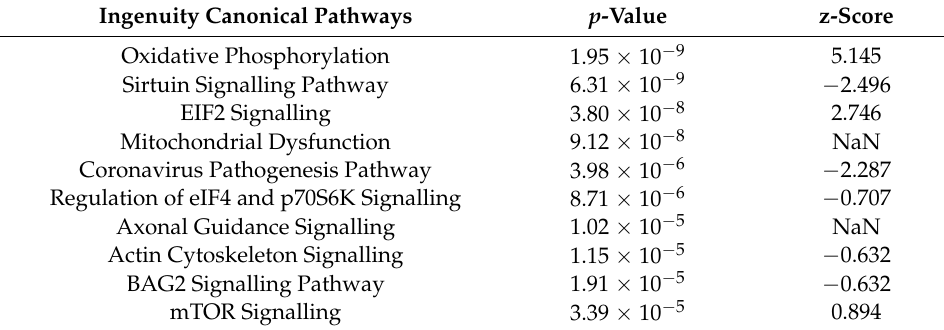
Table 1. Top 10 canonical pathways significantly altered in SW837 cells when compared to HCT116